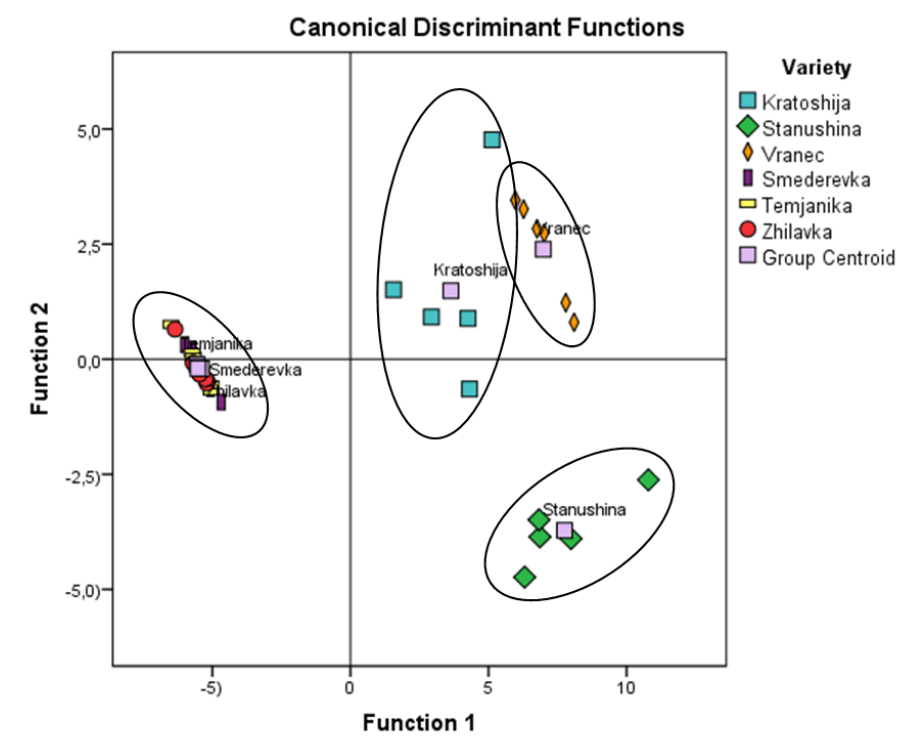
Figure 1. Canonical discriminant score plot for the wine varieties examined based on results of TPC, DPPH and CUPRAC.